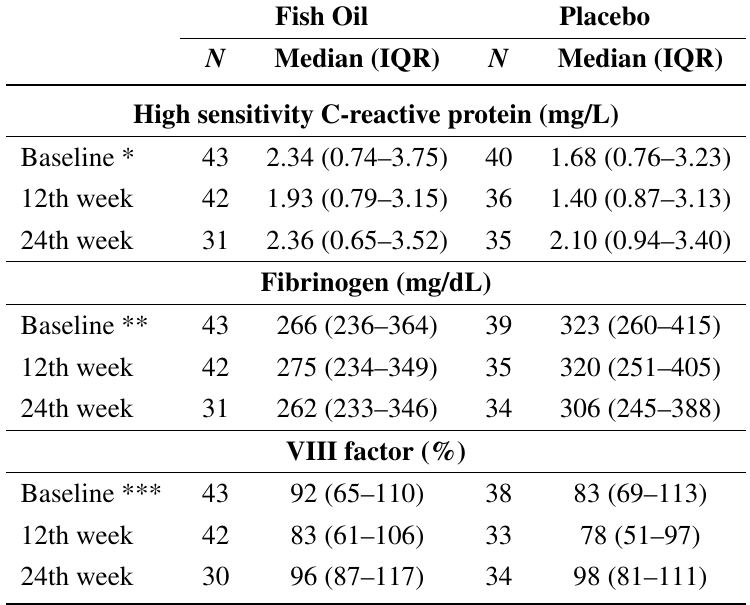
Table 2. Primary endpoints—C Reactive Protein, Fibrinogen, Factor